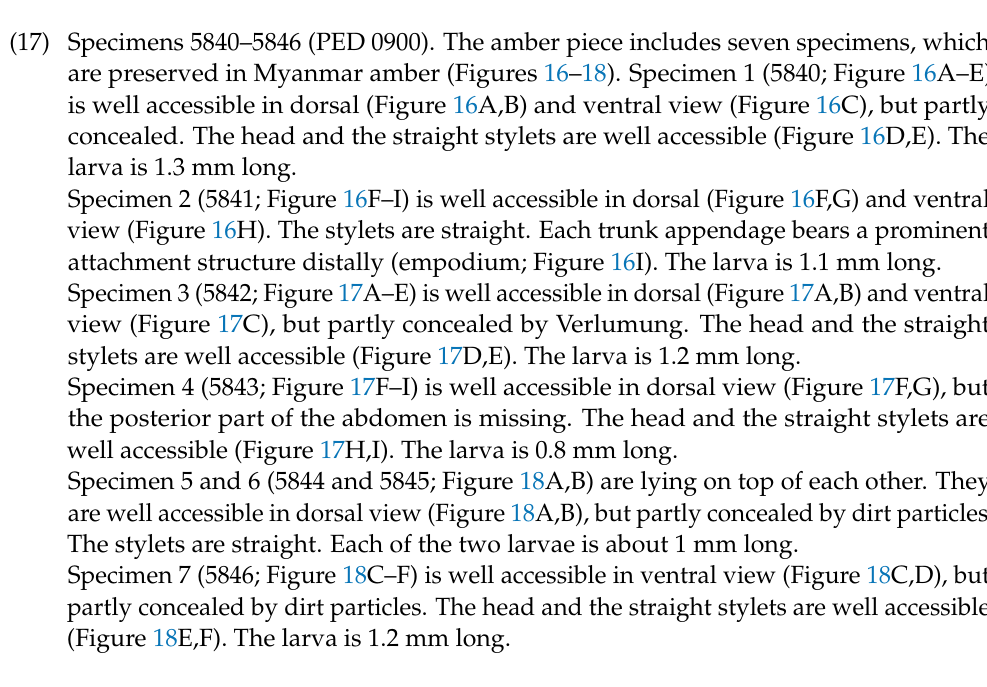
Figure 9. Specimen 5830 (BUB 3741); Myanmar amber. ( A ) Dorsal view. ( B ) Dorsal view, colour-marked. ( C ) Ventral view. ( D ) Close-up of head in dorsal view. ( E ) Close-up of head in dorsal view, colour-marked. ( F ) Close-up of trunk appendages. Abbreviations: a1–a5 = abdomen segments 1–5; at = antenna; cv = cervix; hc = head capsule; ms = mesothorax; mt = metathorax; pt = prothorax; sy =